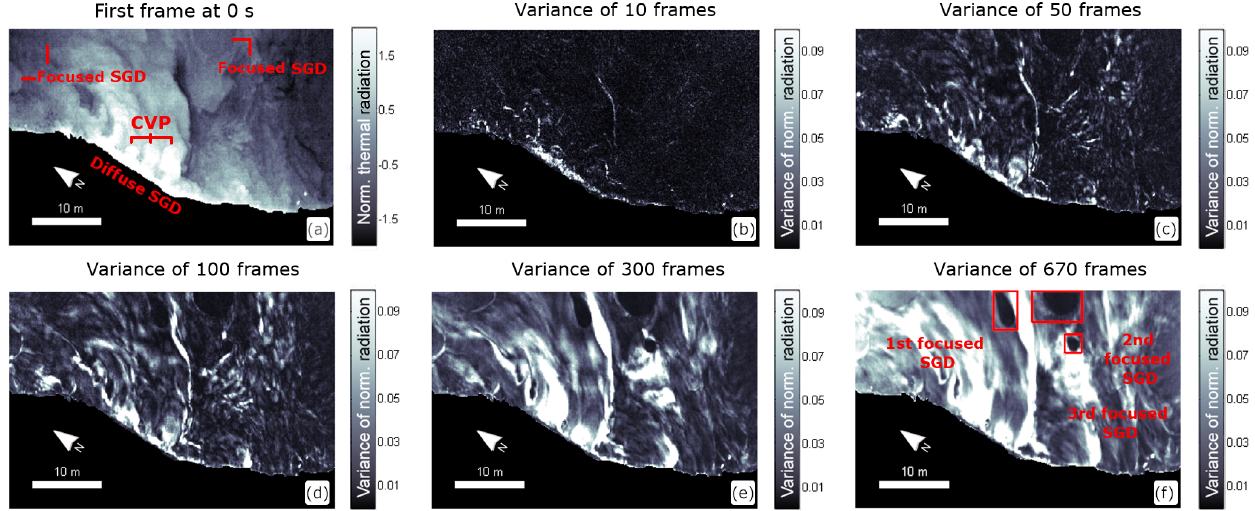
Figure 3. Variance of normalized thermal radiances over time starting with a normalized thermal radiance image (a) showing ambiguous evidence of focused SGD spots, but distinct evidence of diffuse SGD and counter rotating vortex pairs (CVPs). The latter serves as an indication of a focused flow within the diffuse SGD area (a) . The following panels show the integration of 10 ( ∼ 2.5s), 50 ( ∼ 12.5s), 100 ( ∼ 25s), 300 ( ∼ 75s), and 670 frames ( ∼ 167.5s) as variance per pixel. The final image (f) shows three delineated focused SGD spots (red boxes) indicated through variance values < 0 .